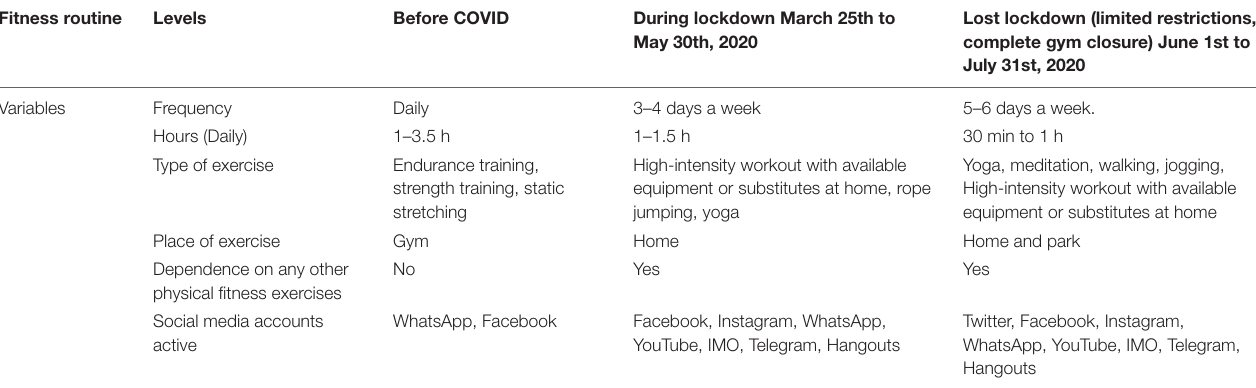
TABLE 2 | Pre- and during COVID fitness exercise information of the participants. Fitness routine